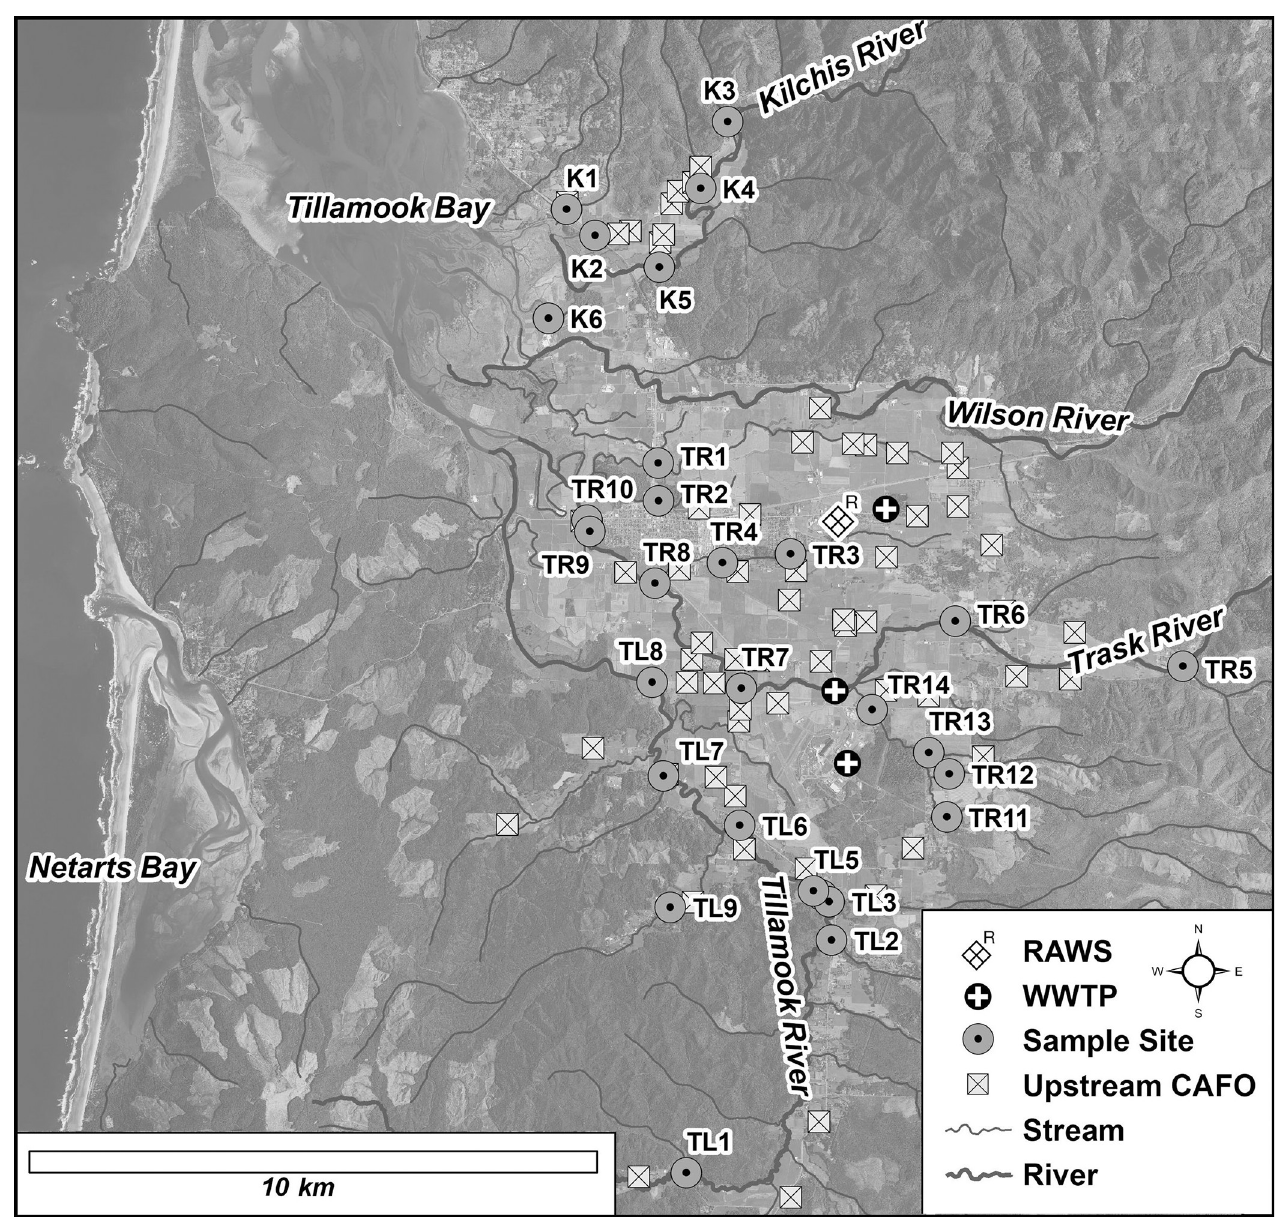
Fig 1. Global information system map of the Tillamook Bay Watershed study area showing locations of sampling sites, waste water treatment plants (WWTP), cattle confined animal feeding operation (CAFO) facilities, and weather station (RAWS). https://doi.org/10.1371/journal.pone.0216827.g001 groups frequently found in the study area including adult cattle (n = 32; Bos taurus ), juvenile cattle (n = 20; < 115 days old; Bos taurus ), canine (n = 11; Canis familiaris ), elk (n = 11; Cervus elaphus ), horse (n = 11; Equus caballus ), chicken (n = 11; Gallus gallus ), gull (n = 3; Laridae), and Canada goose (n = 10; Anser sp.). Each fecal sample was collected from a different individ- ual. Single grab, untreated sewage samples were collected from the City of Tillamook WWTP (n = 2) and Industrial Sewage Treatment Plant (n = 2). Briefly, 25 mL of sewage was filtered through a 0.45 μ m polycarbonate filter (Fisher Scientific, Pittsburg, PA) within 8 hours of